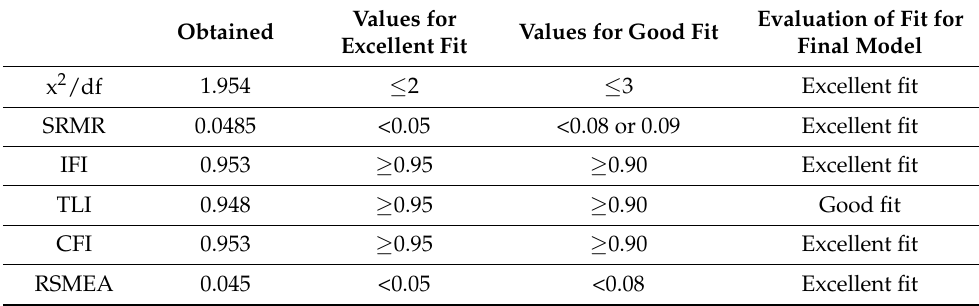
Table 6. Statistics for the final